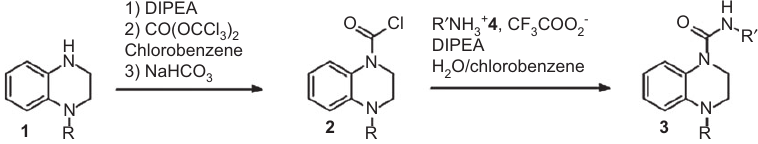
Figure 1 General scheme of urea 3 formation via the use of